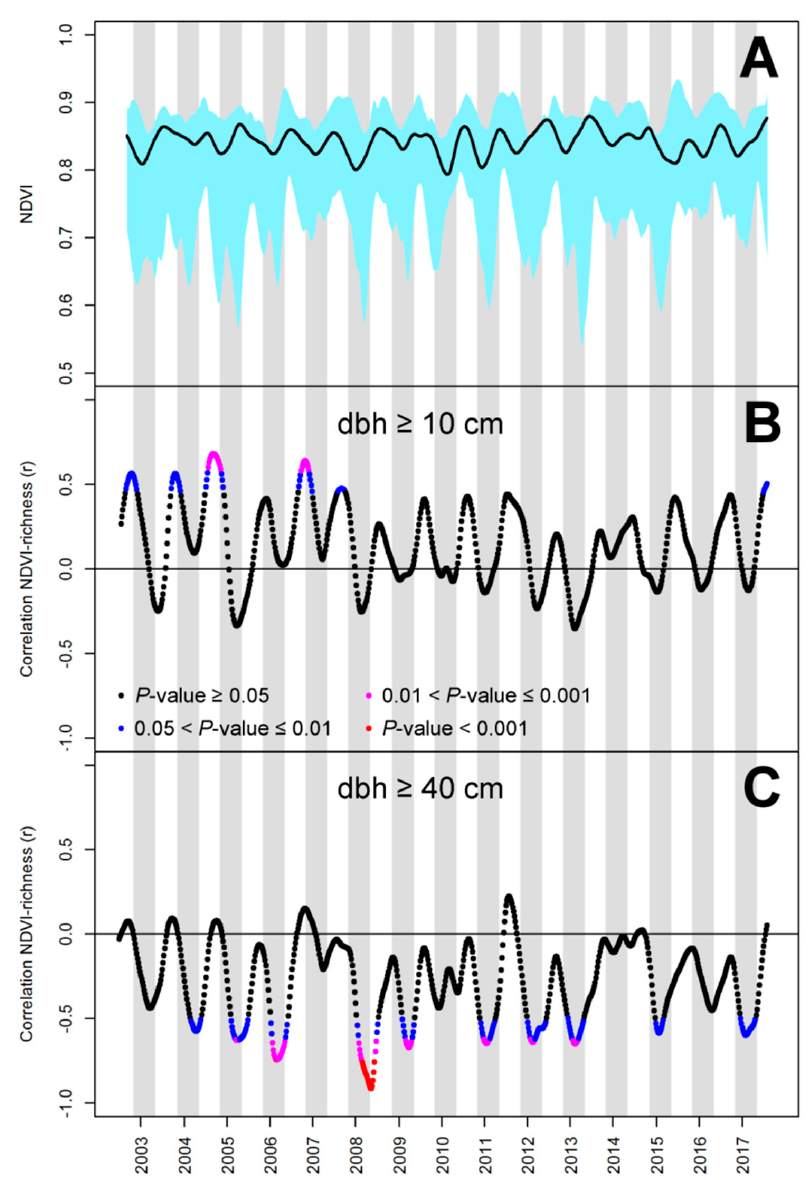
Figure 2. Temporal variation of MODIS NDVI in 19 one-hectare plots in New Caledonia ( A ) and in its ability to predict species richness of trees with a diameter at breast height (dbh) above 10 cm ( B ) and 40 cm ( C ). ( A ) The black line represents the mean and the blue shaded area the interval within which plot values are found; ( B , C ) The color set refers to four significance levels of correlation tests. ( A , C ) The gray shaded area indicates the months of November to April (usual wet season).